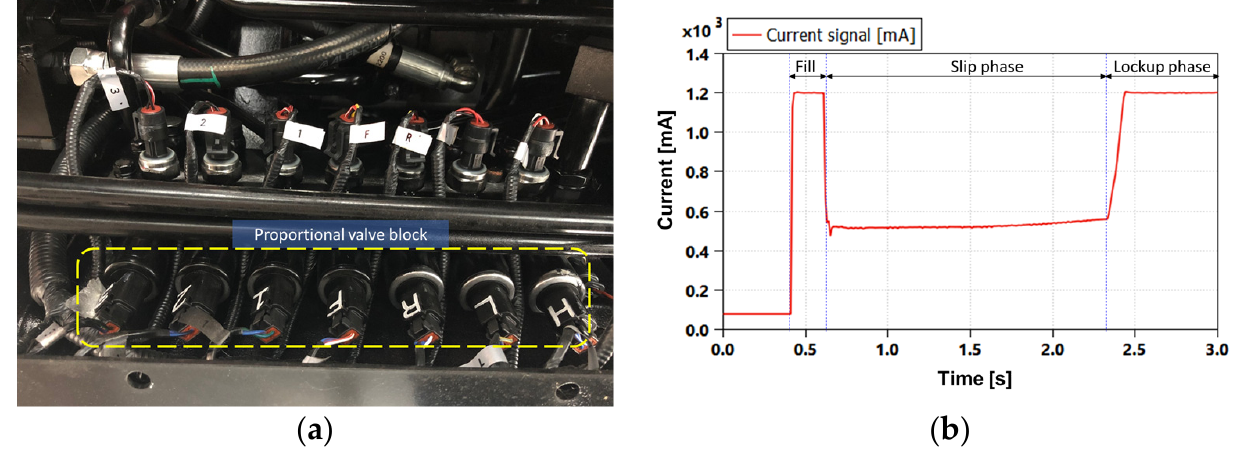
Figure 5. Proportional valves assembly with command current signal. ( a ) Proportional valve block of T130, ( b ) command signal of proportional valve.